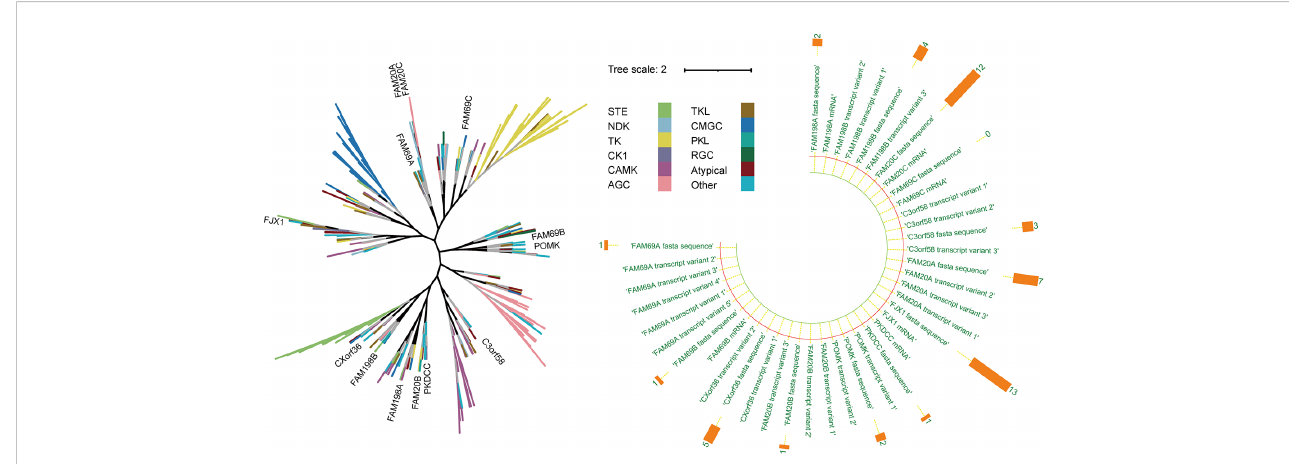
FIGURE 1 Representation of the evolutionary relation analysis of the secretory pathway kinase or kinase-like proteins in human kinome. Left: The black branches represent the development process of the phylogenetic tree of all kinases (branches of different colors represent different kinase groups). Right: The orange bar chart represents the number of disease literature related to the corresponding